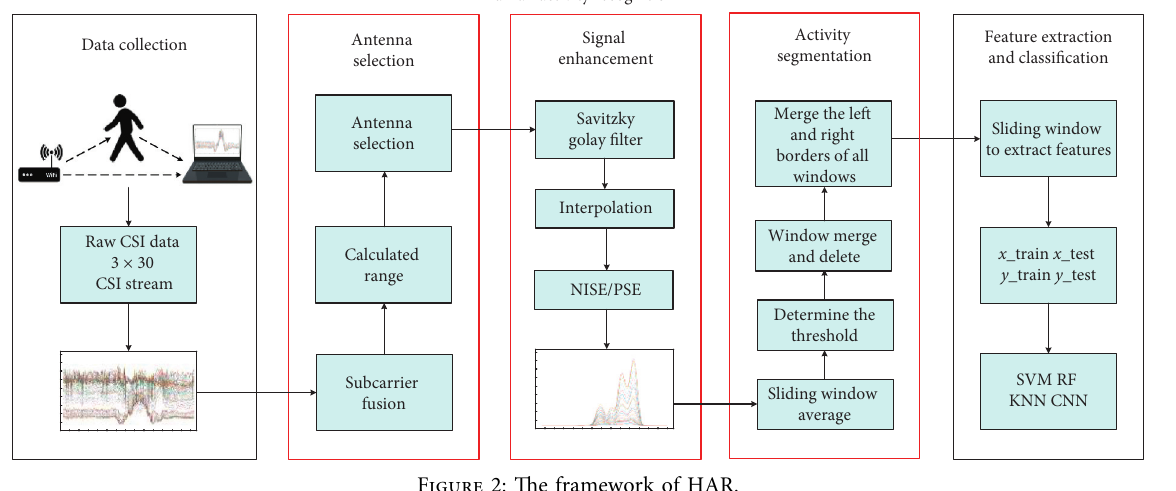
Figure 2: The framework of HAR.